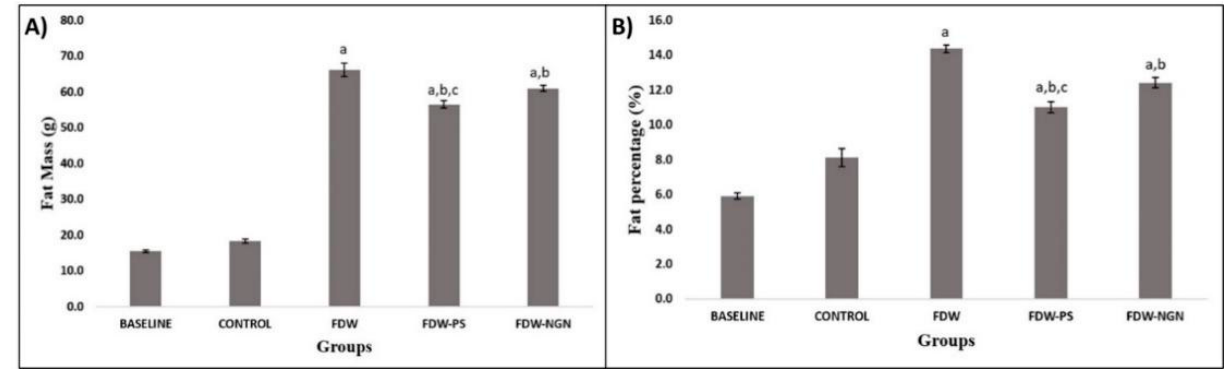
Figure 2. Fat mass ( A ) and fat percentage ( B ) differences of all groups over 12 weeks. Values are mean ± SD and n = 8 for each group. Superscript letters indicate significantly different. a p < 0.05 compared to the control group. b p < 0.05 compared to the FDW group. c p < 0.05 compared to the FDW-NGN group. FDW: Olive oil + 20% fructose; FDW-PS: PS + 20% fructose; FDW-NGN: Naringin + 20% fructose.